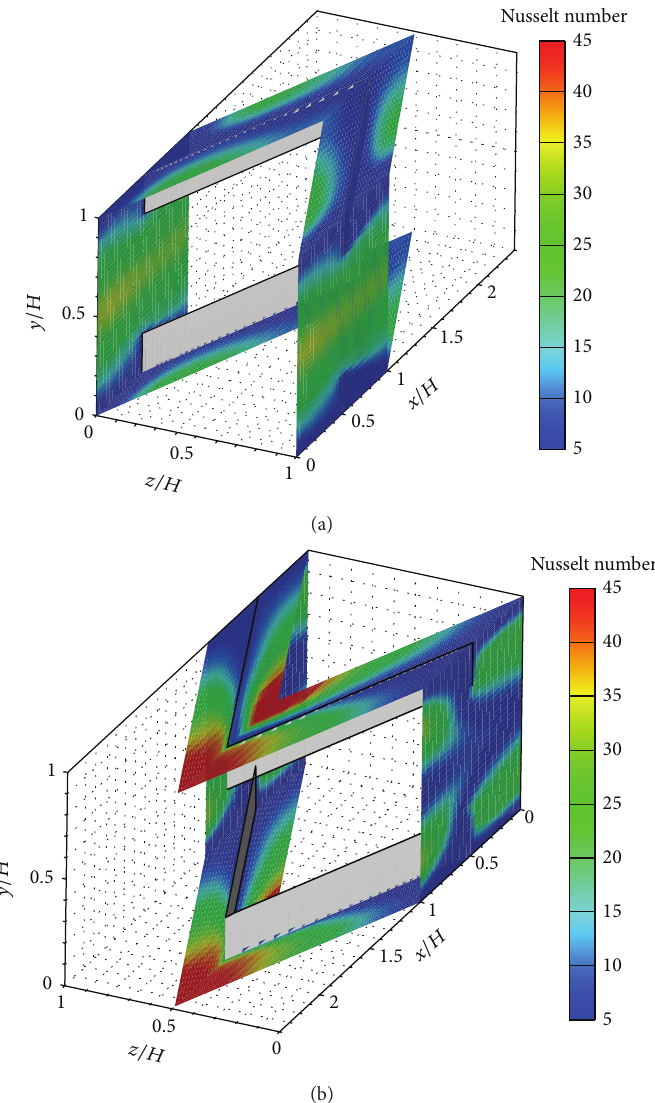
Figure 8: Contour plot Nu 𝑥 for (a) V-Downstream and (b) V-Upstream of 20 ∘ V-rib at Re = 800 , BR = 0.20 , and PR = 1 .